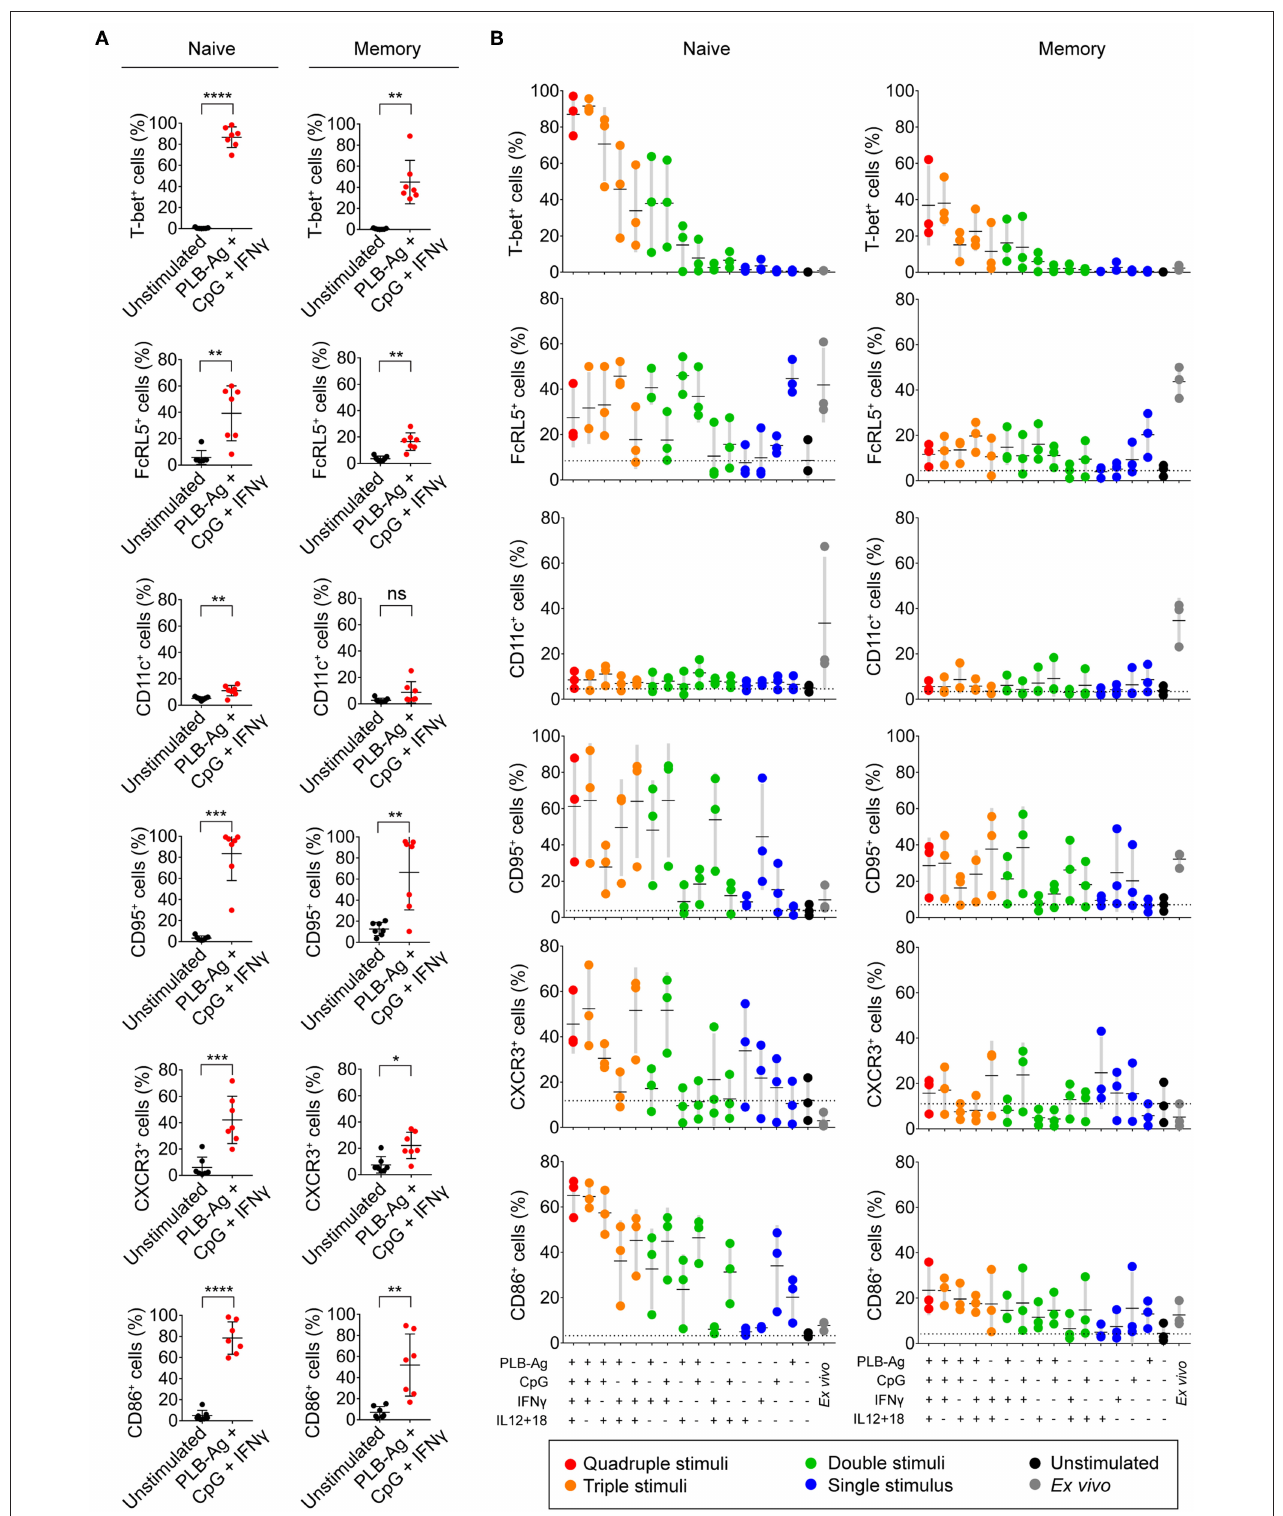
FIGURE 3 | Tonsil naïve and memory B cells upregulate malaria-associated atypical MBC markers upon BCR, TLR9, and IFN- γ stimulation in vitro. (A) Tonsil B cells were cultured in vitro for 40h unstimulated or stimulated with antigen presented on PLB in the presence of CpG and IFN- γ . Comparison of the expression of T-bet, FcRL5, CD11c, CD95, CXCR3, and CD86 determined by flow cytometry for naïve (IgD + CD10 − ) and memory (IgD − CD10 − ) B cells are given as the percent of B cells